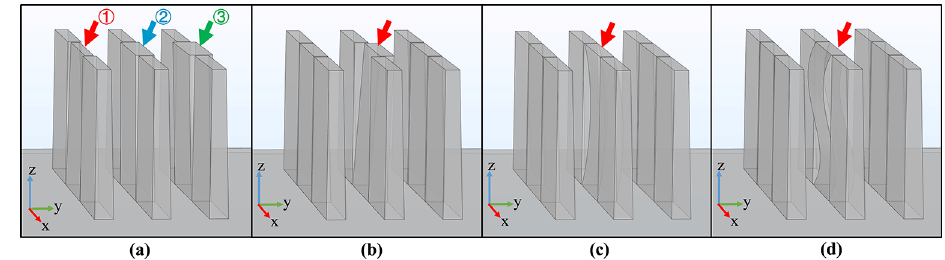
Figure 4. 3D geometrical models of the structures with different shapes. ( a ) Trapezoidal structure with different base angles: ① 88°, ② 90°, and ③ 92°; ( b ) tilted structure; ( c ) C-shape distorted structure; ( d ) S-shape distorted structure.